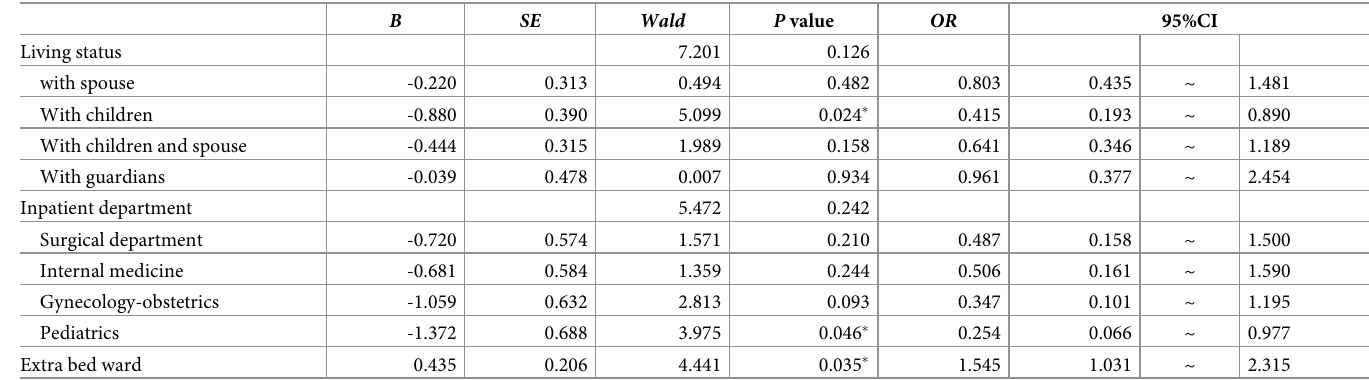
Table 6. Risk factors for patients’ favorite nurses with a good environment-centered